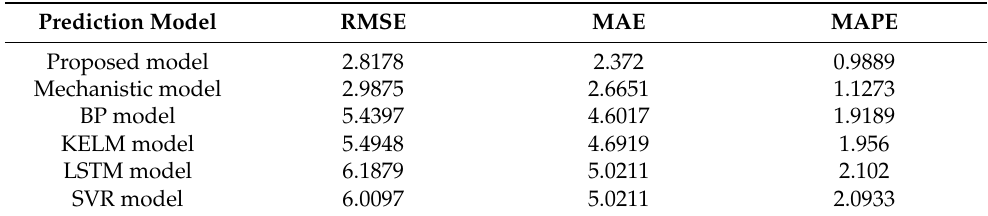
Table 2. Comparison of prediction performance indicators for different prediction models when the data fluctuate greatly.